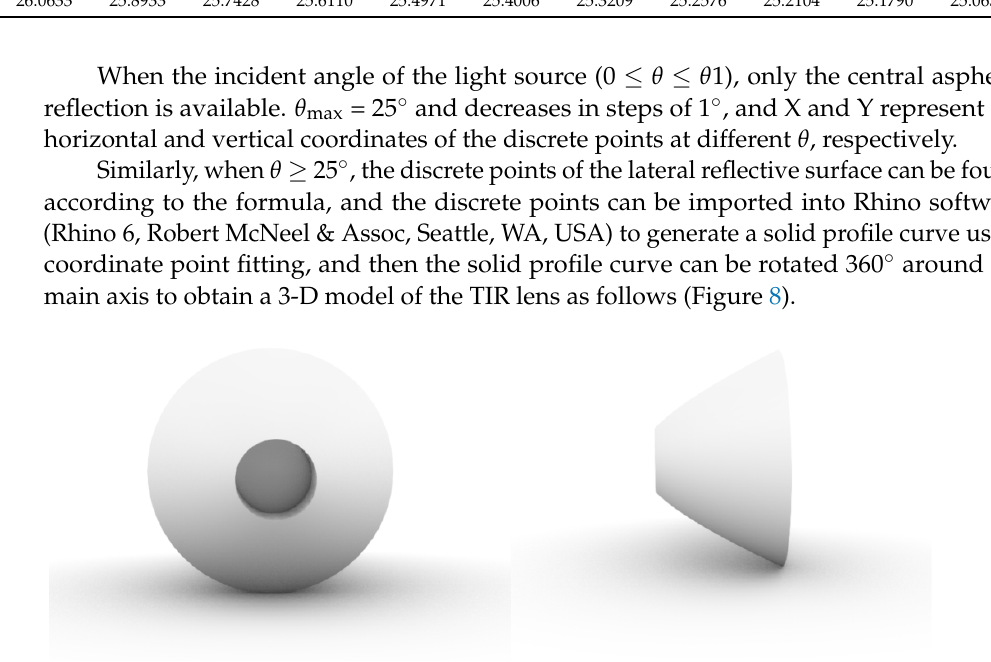
Table 2. Center aspheric discrete points.